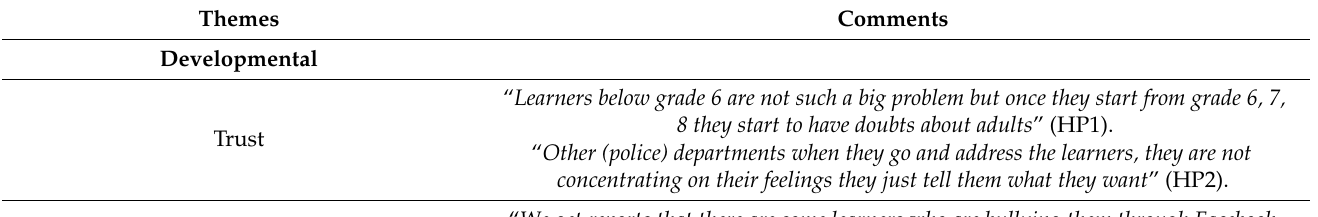
Table 4. Sample responses from the police and